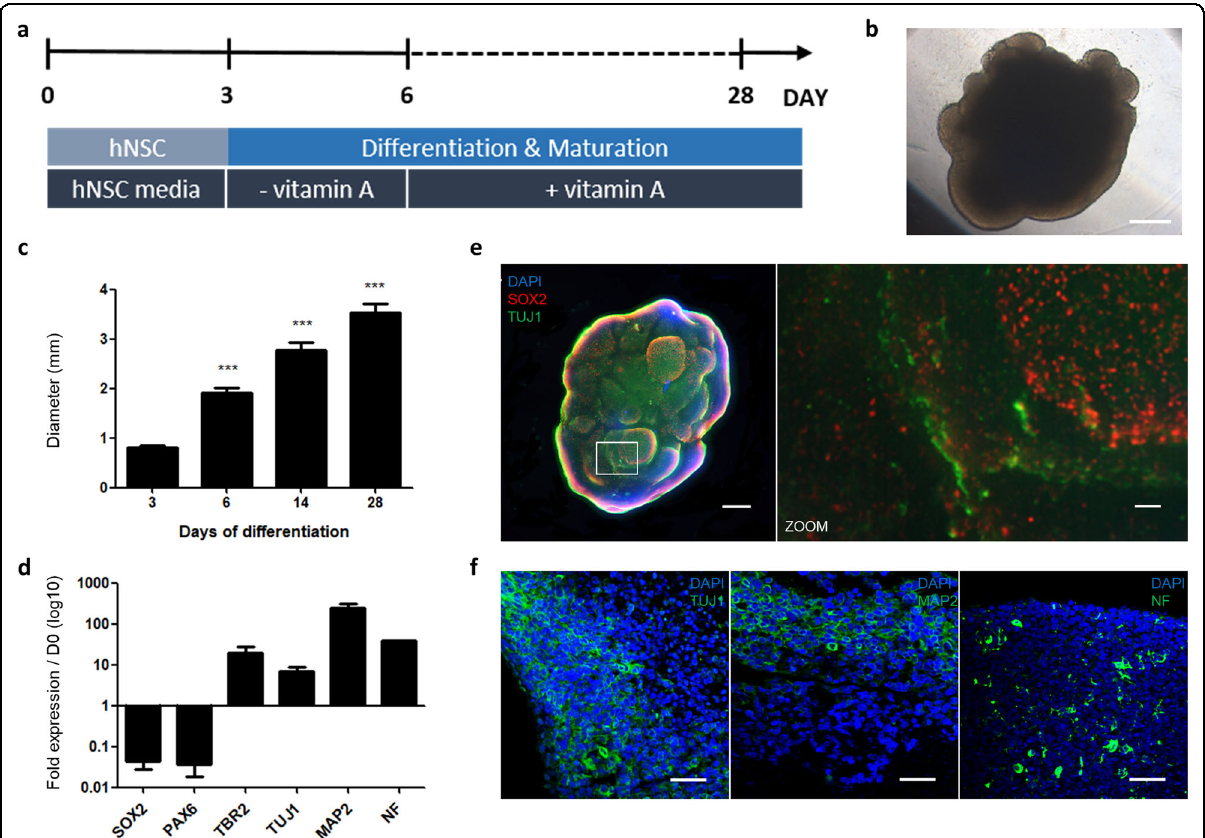
Fig. 1 Generation of brain organoids from WT iNSCs. a Schematic of the method for the generation of WT organoids using iNSCs. b Bright- fi eld images of the organoids at day 28 of maturation. Scale bars, 500 μ m. c Quanti fi cation of the diameter (mm) during the entire course of the brain organoid development under different culture conditions. The results are the mean ± SD. *** p < 0.001. n = 10 diameters of organoids were quanti fi ed per time point. d RT-qPCR analysis of neural progenitor cell markers, SOX2 and PAX6 , an intermediate progenitor marker, TBR2 , and neuron markers, TUJ1, MAP2 , and NF , in the organoids at day 28. The data are normalized to iNSCs at day 0. The results are the mean ± SEM. n = 3 per sample. e Clearing and immunohistochemistry revealed the whole-mount morphology with heterogeneous regions containing neural progenitors (SOX2, red) and neurons (TUJ1, green). Scale bars, 500 μ m. Zoom scale bars, 60 μ m. f Immunohistochemical staining of serial sections for neuronal markers (TUJ1, MAP2, and NF) at day 28 of differentiation. Scale bars, 50 μ